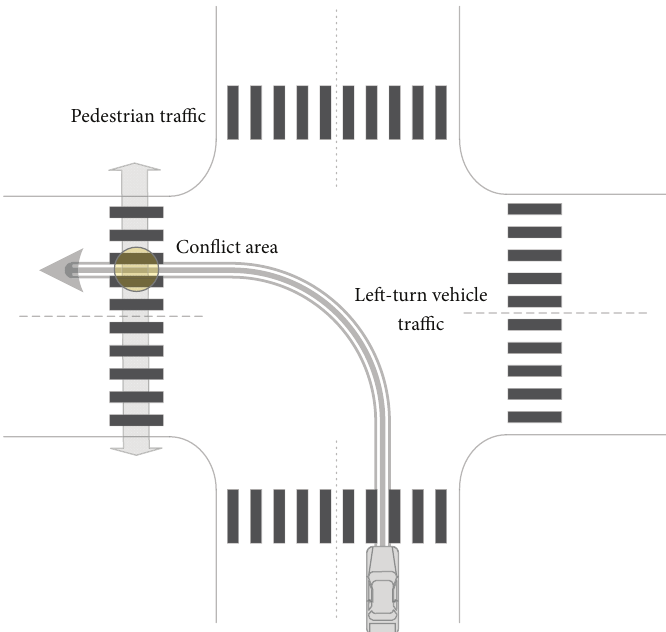
Figure 1: Illustration of left-turn vehicle and pedestrian